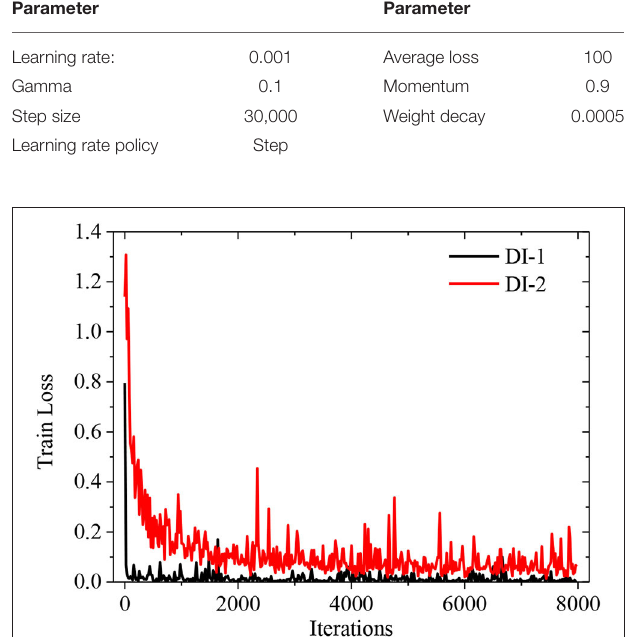
FIGURE 7 | The training loss curves of DI-1 and